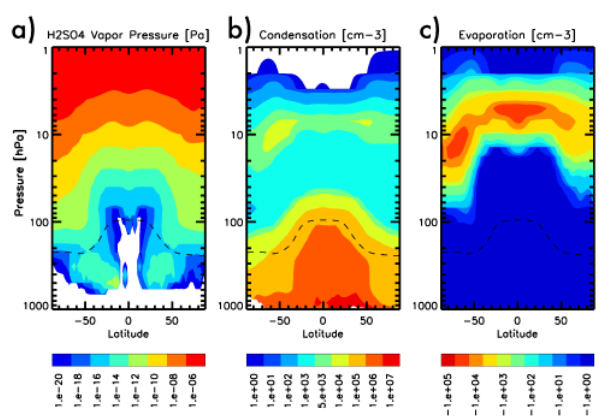
Fig. 8. Calculated climatological zonal mean (a) H 2 SO 4 vapour pressure and the transfer concentrations of the processes (b) H 2 SO 4 condensation and (c) H 2 SO 4 evaporation. The evaporation transfer concentration is negative when mass transfer onto aerosols (b) is defined positive. Note an inverted colour shading in (c)